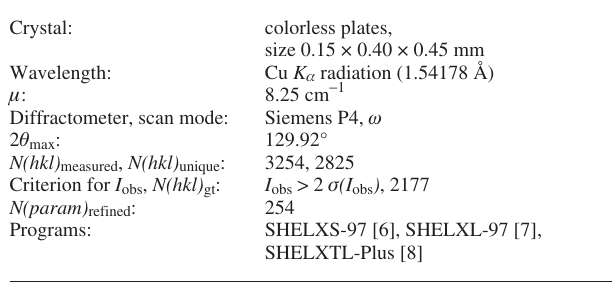
Table 1. Data collection and handling.